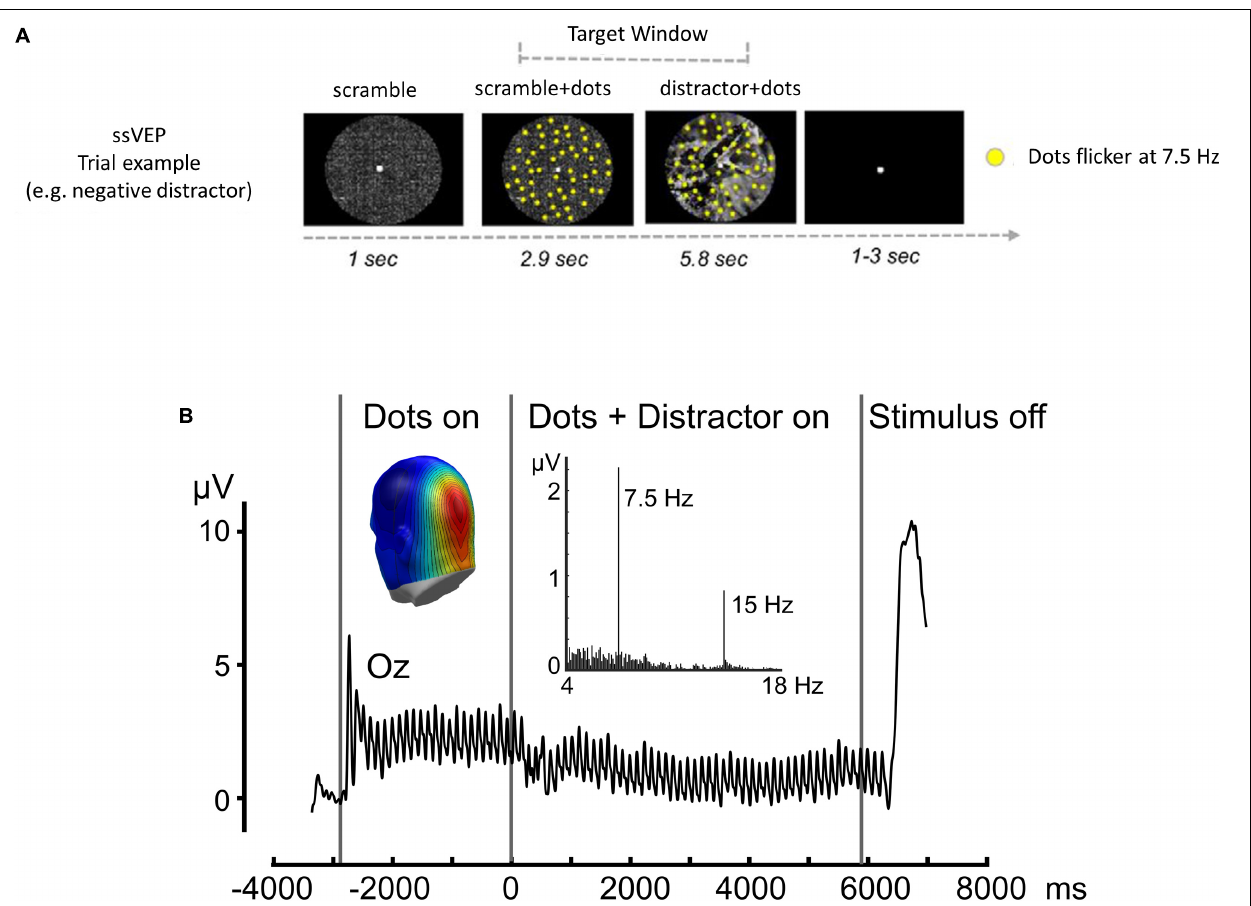
FIGURE 1 | ssVEP task. (A) Time sequence for a single trial: intervals of coherent motion could occur between 1.17 and 7 s post-stimulus onset (target window). Each trial lasted 9.751 s with a variable 3–5-s inter-trial interval. (B) Time-domain representation of the steady-state visual evoked potentials, when viewing dots flickering at a rate of 7.5 Hz, recorded from sensor Oz. Black vertical lines indicate the duration of the stimulus presentation. Insets display the frequency spectrum of the same data, with a pronounced peak at the flickering frequency (7.5 Hz) and the first harmonic frequency (15 Hz) clearly visible. The inset shows a back view of the spectral amplitude topography of this response as projected to a standard head. Note the focal parieto-occipital distribution of the steady-state visual evoked potential signal evoked by flickering dots. Adapted with permission from Simon et al.